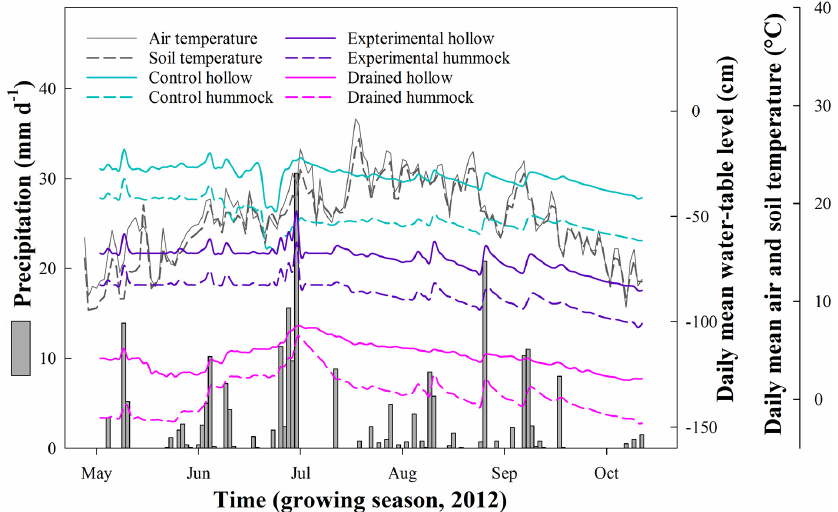
Figure 2. Daily mean site air temperature (°C), soil temperature (°C) at 5 cm depth, total precipitation (mm), representative hollow and hummock water ‐ table (WT) level (cm) over the 2012 growing season (May to October). Note the two y ‐ axes on the right side: daily mean WT level, and air and soil temperatures.